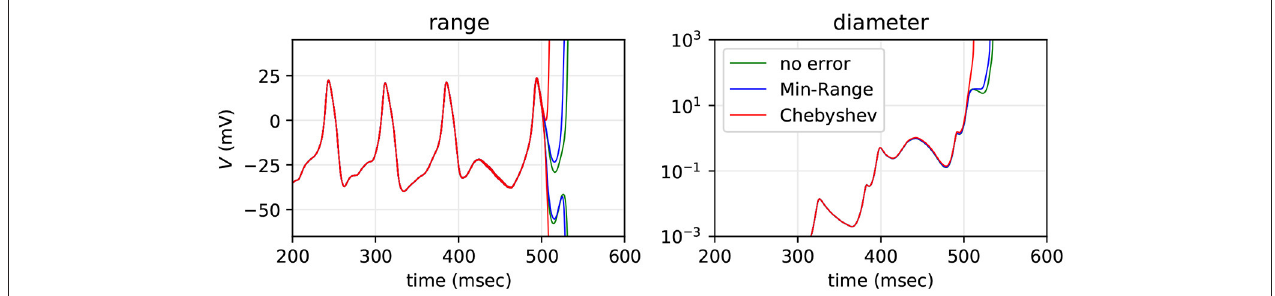
FIGURE 8 | Range and diameter of the Morris-Lecar neuron’s V variable, computed with transcendental functions using Chebyshev approximation (red), Min-Range (blue) and Chebyshev with approximation error set to zero (green). The model is a fan-in SNN with n